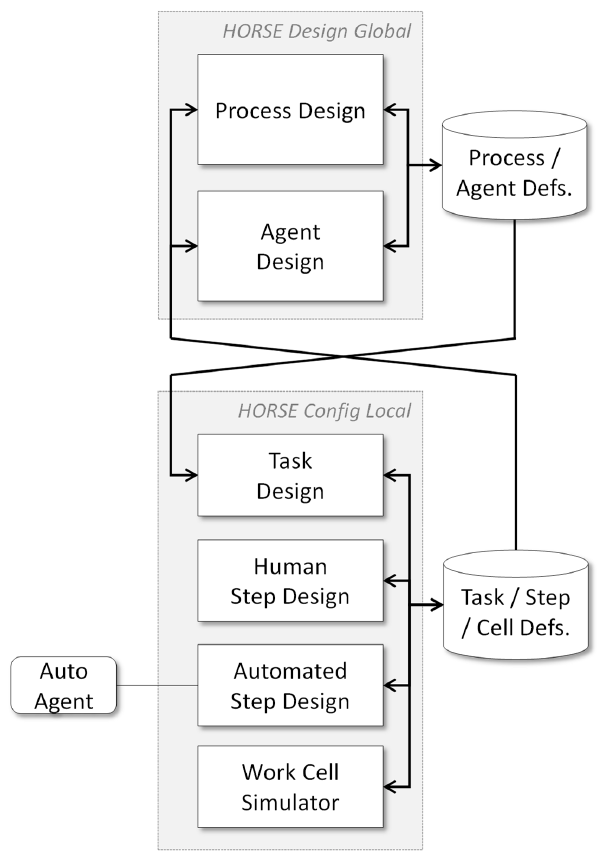
Figure 7. HORSE architecture, design time aspect, aggregation level 2.